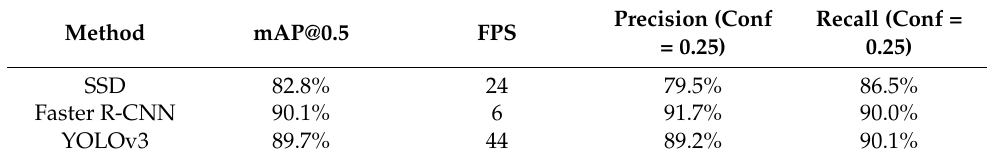
Table 3. Results of different target detection